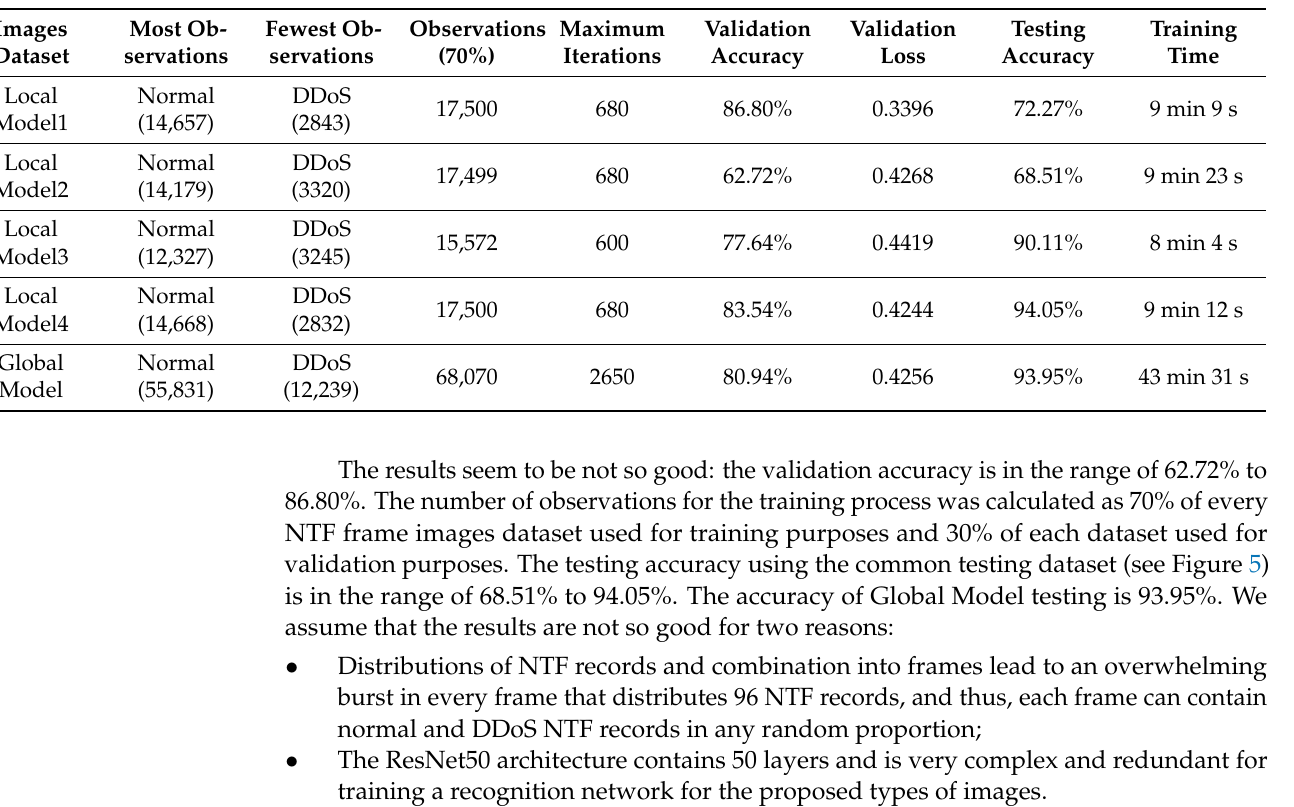
Figure 10. Confusion matrix visualizing the performance of TTL with ResNet50 architecture to train the Global Model. Table 2. Experimental results of the TTL with ResNet50